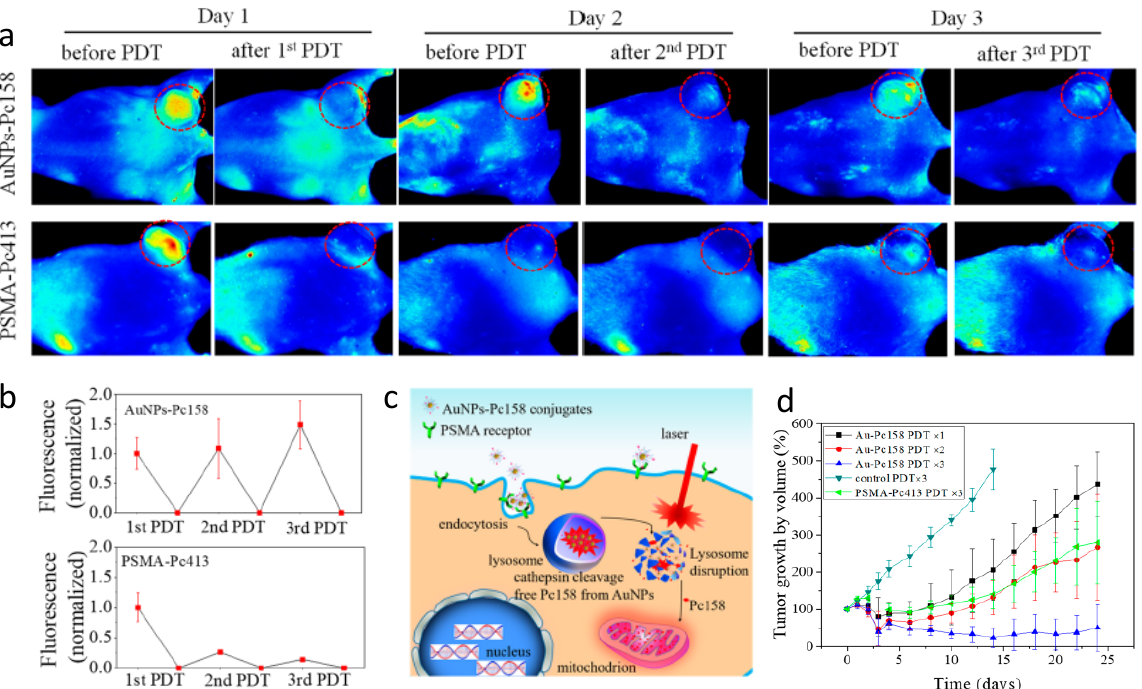
Figure 6. ( a ) Comparison of fluorescence images of mice received PSMA-targeting AuNPs-Pc158 and PSMA-1-Pc413 before and after each PDT. ( b ) Normalized fluorescence intensity of PSMA-targeting AuNPs-Pc158 and PSMA-1-Pc413. ( c ) Illustration of lysosome release of Pc158 by cathepsin and accumulation of Pc158 into mitochondria. ( d ) Multiple PDT with PSMA-targeting AuNPs-Pc158 effectively inhibits large tumor (>500 mm 3 ) growth. Reprinted with permission from Ref. [123]. Copyright 2020 American Chemical Society.